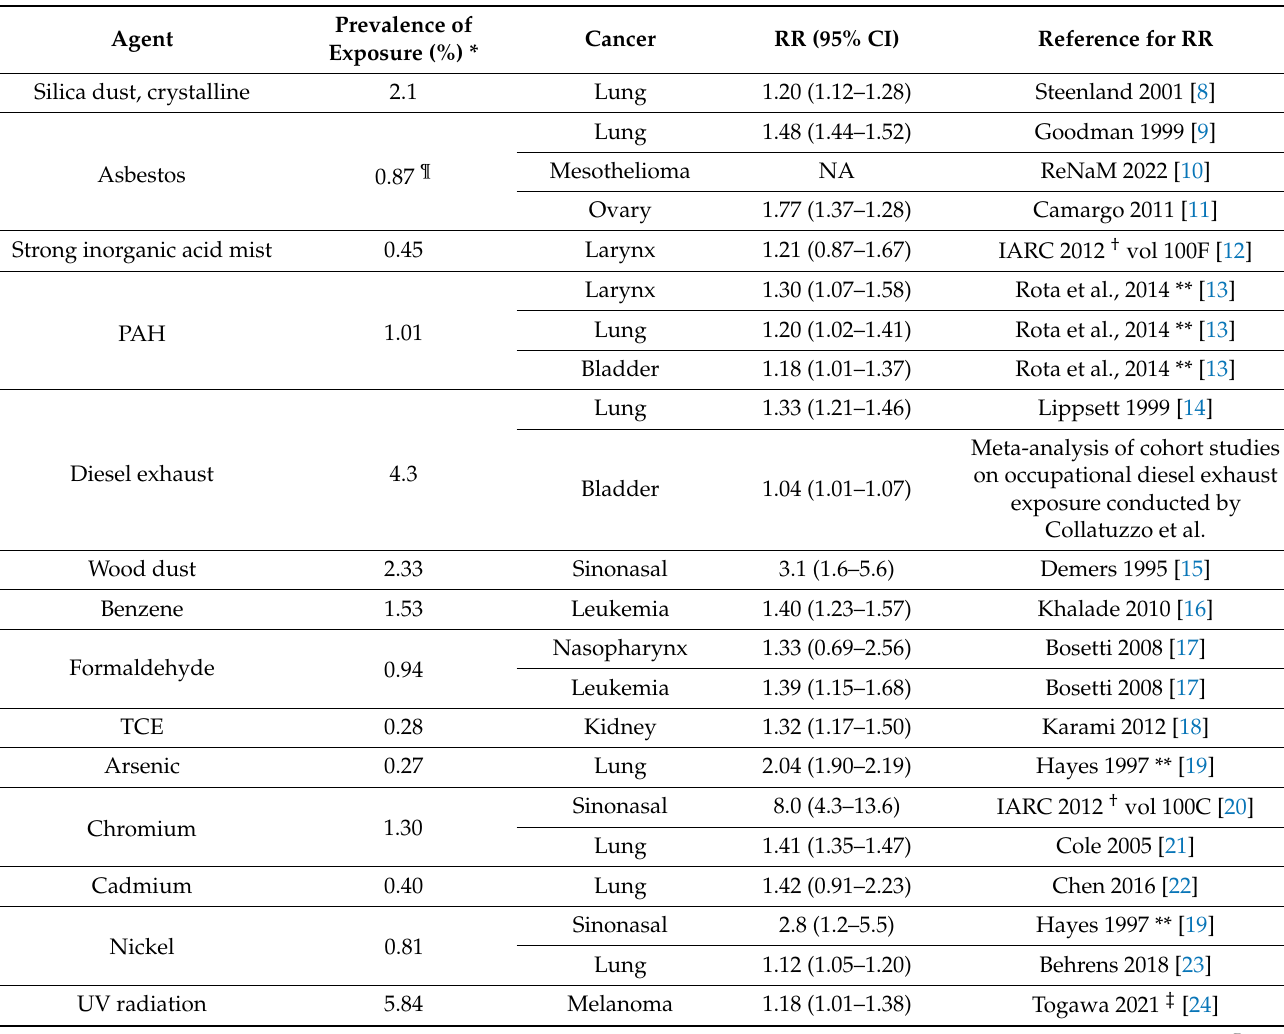
Table 1. Prevalence of exposure of the occupational agent included in the analysis and relative risk (RR) for cancers associated with